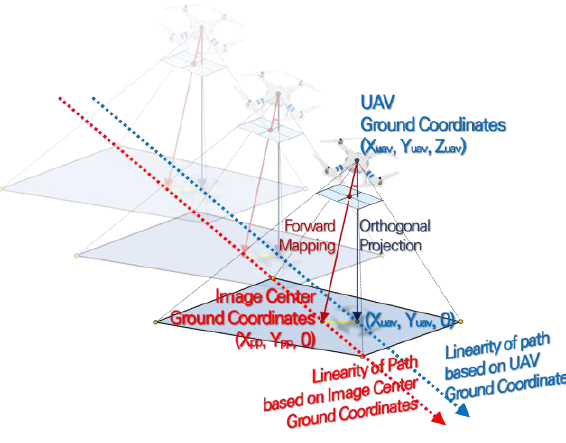
Figure 3. Linearity of path analysis